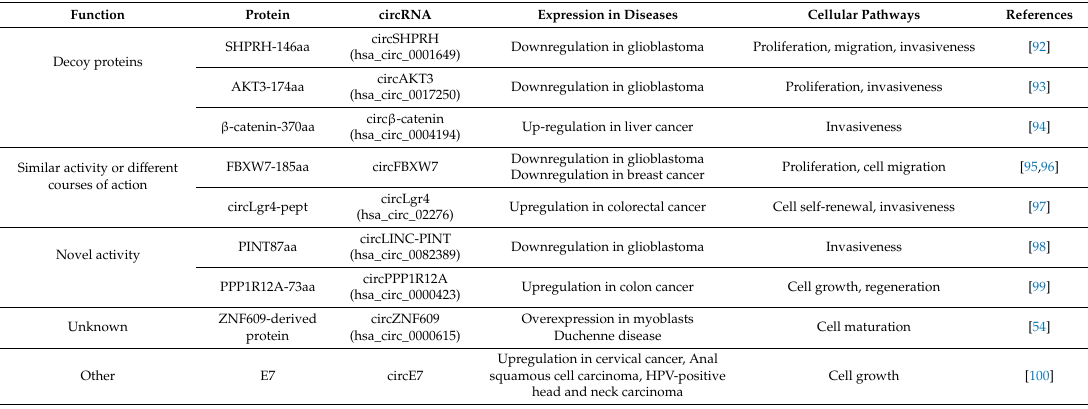
Table 1. Summary of proteins encoded by circRNAs in human